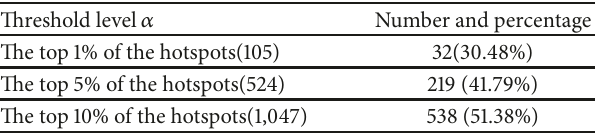
Table 8: The number of the same sites identified as hotspots using the carcass removal data and the reported AVCs data.